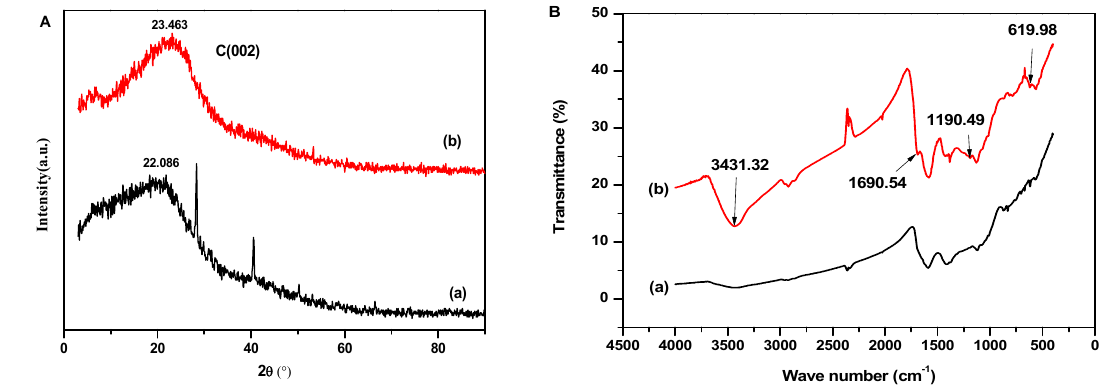
Figure 5. X ‐ ray diffraction (XRD) patterns ( A ) and Fourier ‐ transform infrared spectra (FT ‐ IR) spectra ( B ) for carbonized carrier (a) and sulfonated carbon-based solid catalyst (b) prepared from sweet ( B ) for carbonized carrier (a) and sulfonated carbon ‐ based solid catalyst (b) prepared from sweet potato.